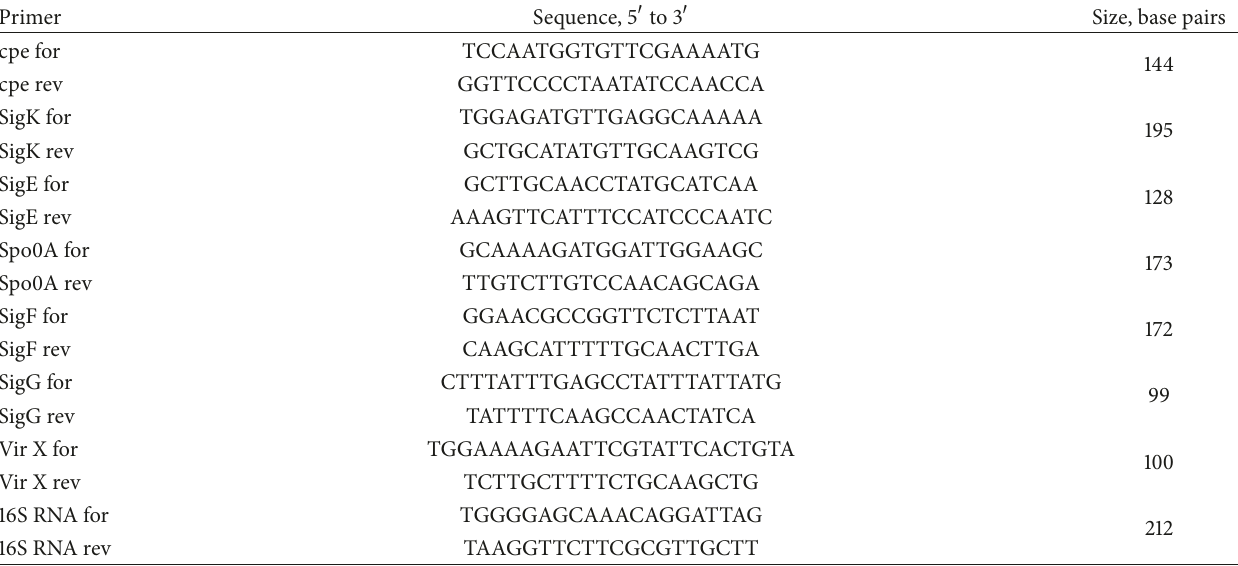
Table 1: Forward (for) and reverse (rev) primers used for the PCR and qRT-PCR amplification of enterotoxin genes and sigma factors in C.